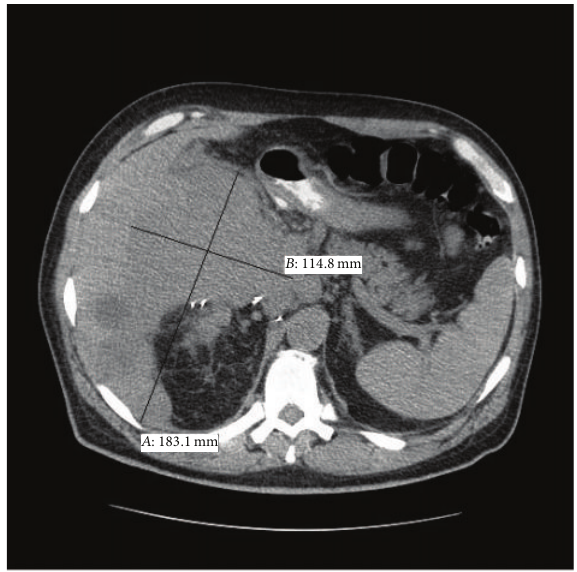
Figure 1: CT image showing involvement of kidney and liver by the